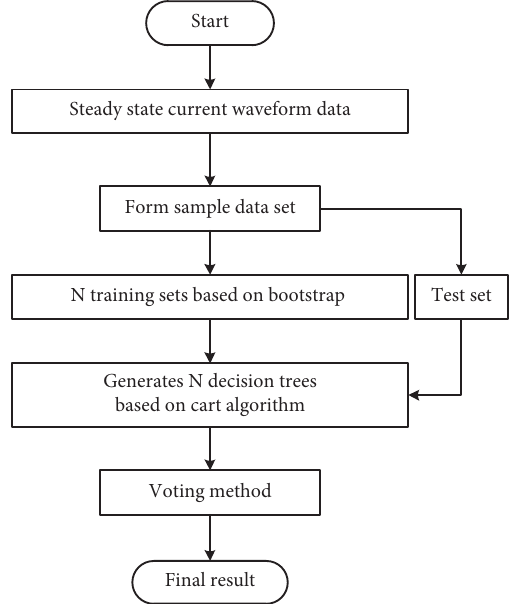
Figure 4: Flowchart of industrial load identification based on the random